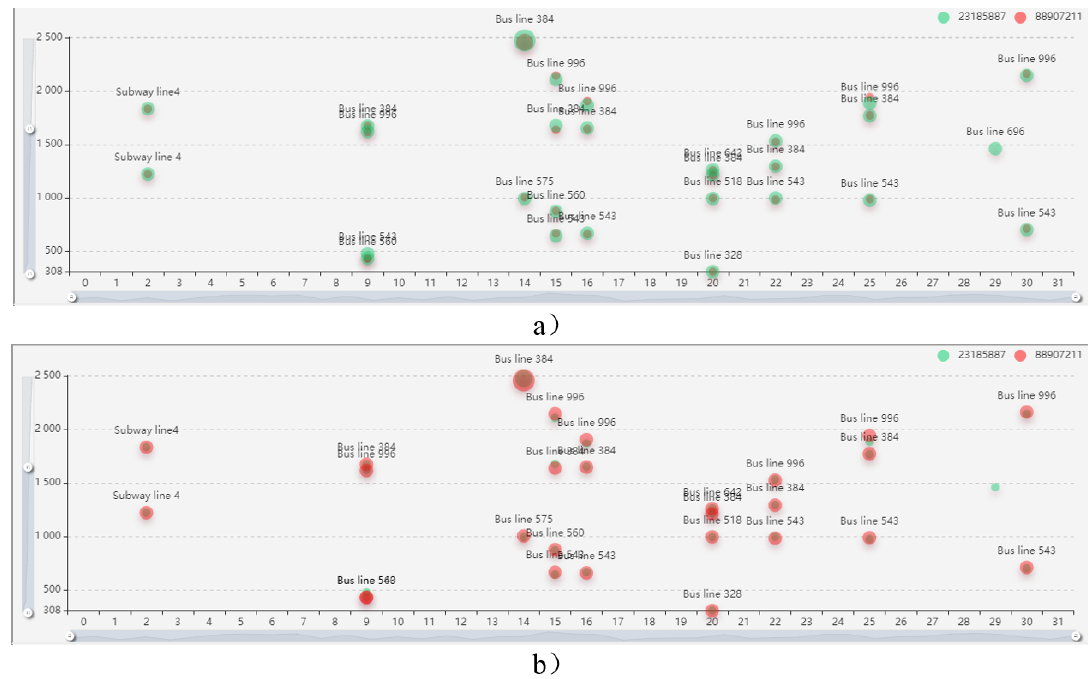
Figure 13. Normal passenger analysis—bubble chart view ( a ) Card number 23185887, ( b ) Card number 889072211.